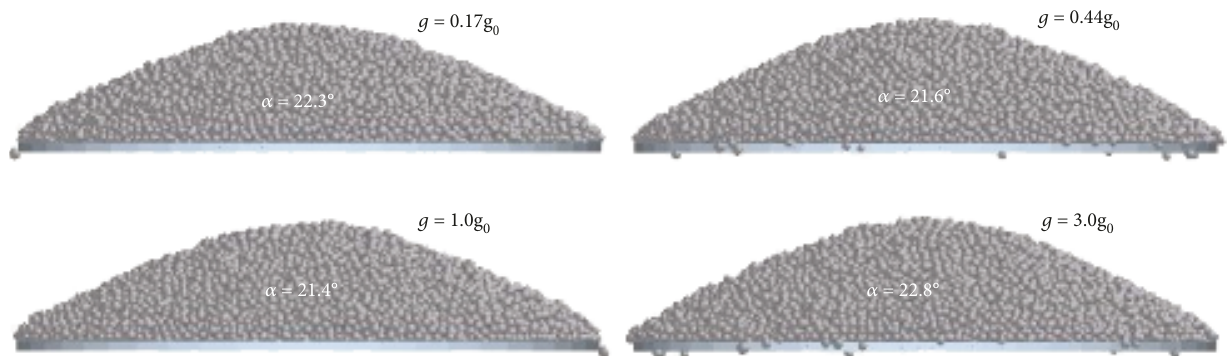
Figure 4: Particulate pile under di ff erent gravity conditions for particle sample S